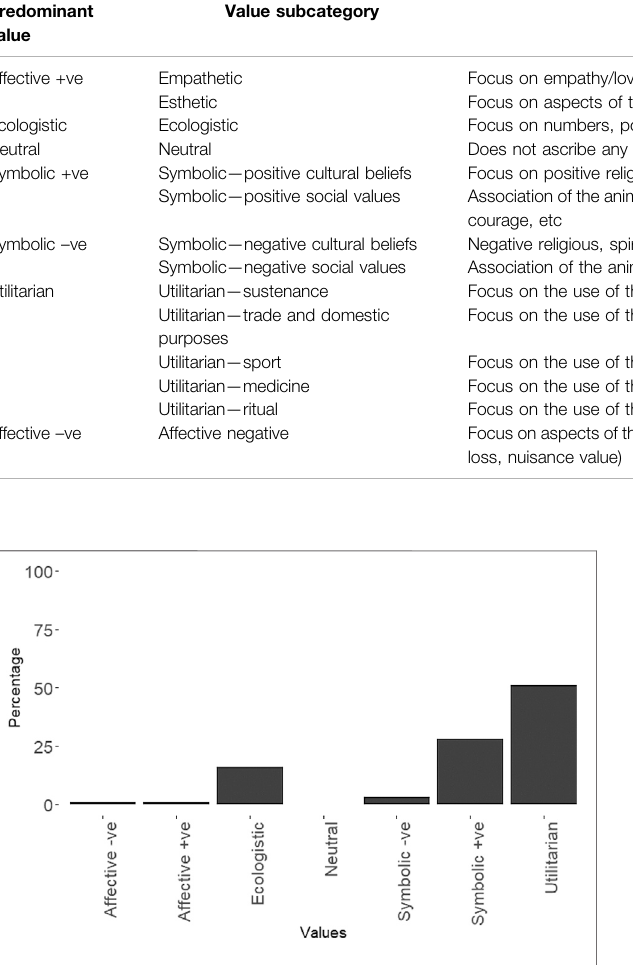
TABLE 1 | Affective values focus on emotions while symbolic values focus on religious, spiritual or cultural beliefs; ecologistic values refer to ecological observations and utilitarian values focus on the use-value of the animal (adapted from Kellert, 1985). Predominant